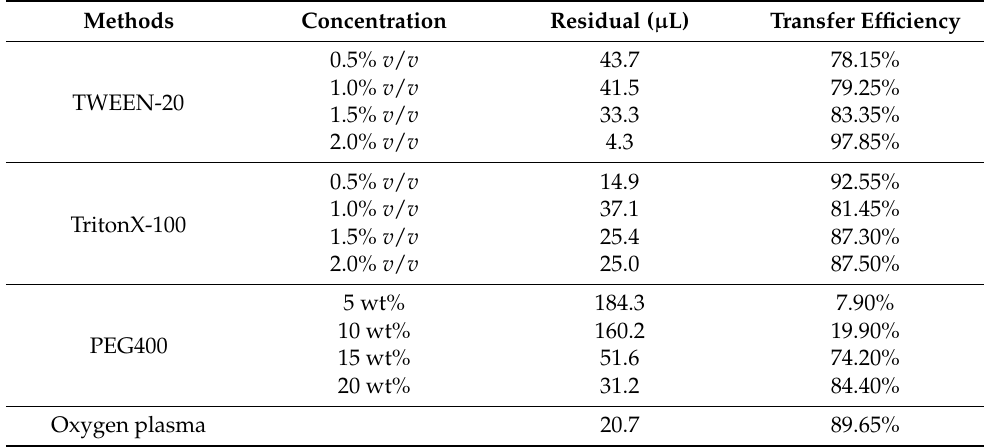
Table 1. Statistics of liquid transfer